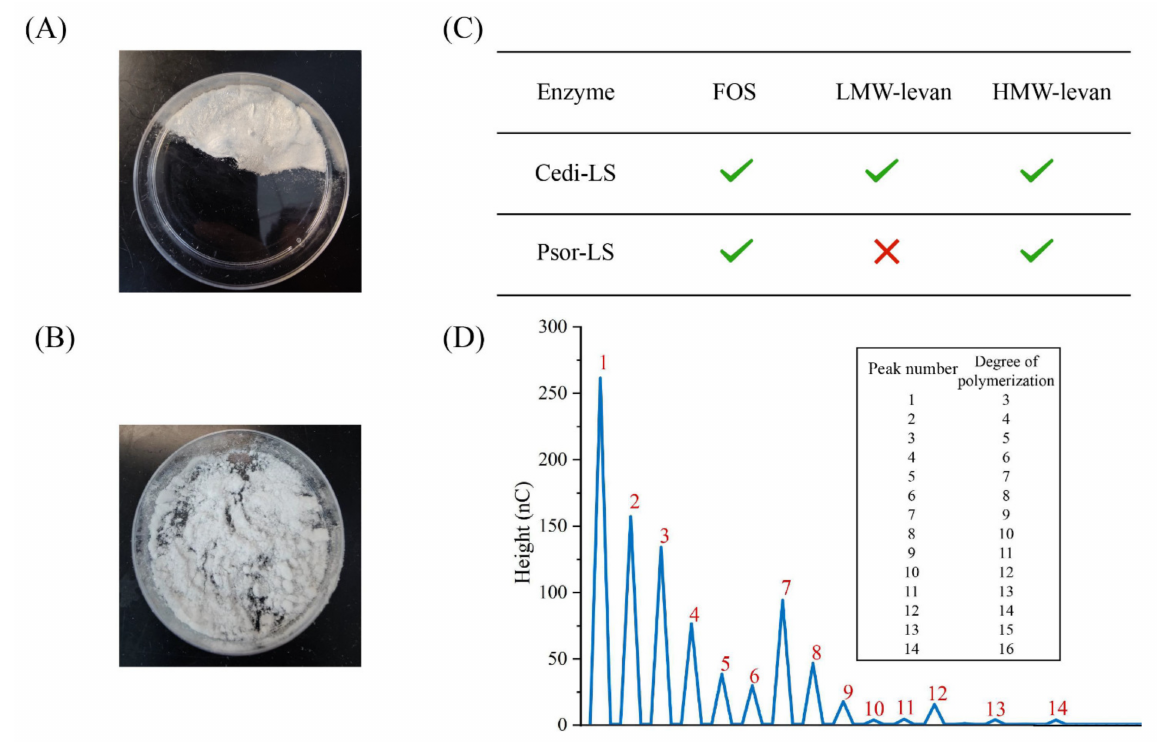
Figure 10. Products from the recombinant LSs. ( A ) The purified HMW levan from Psor-LS. ( B ) The purified FOS from Psor-LS. ( C ) The component analysis of products from Cedi-LS and Psor-LS. ( D ) The HPIC spectrogram of purified FOS from